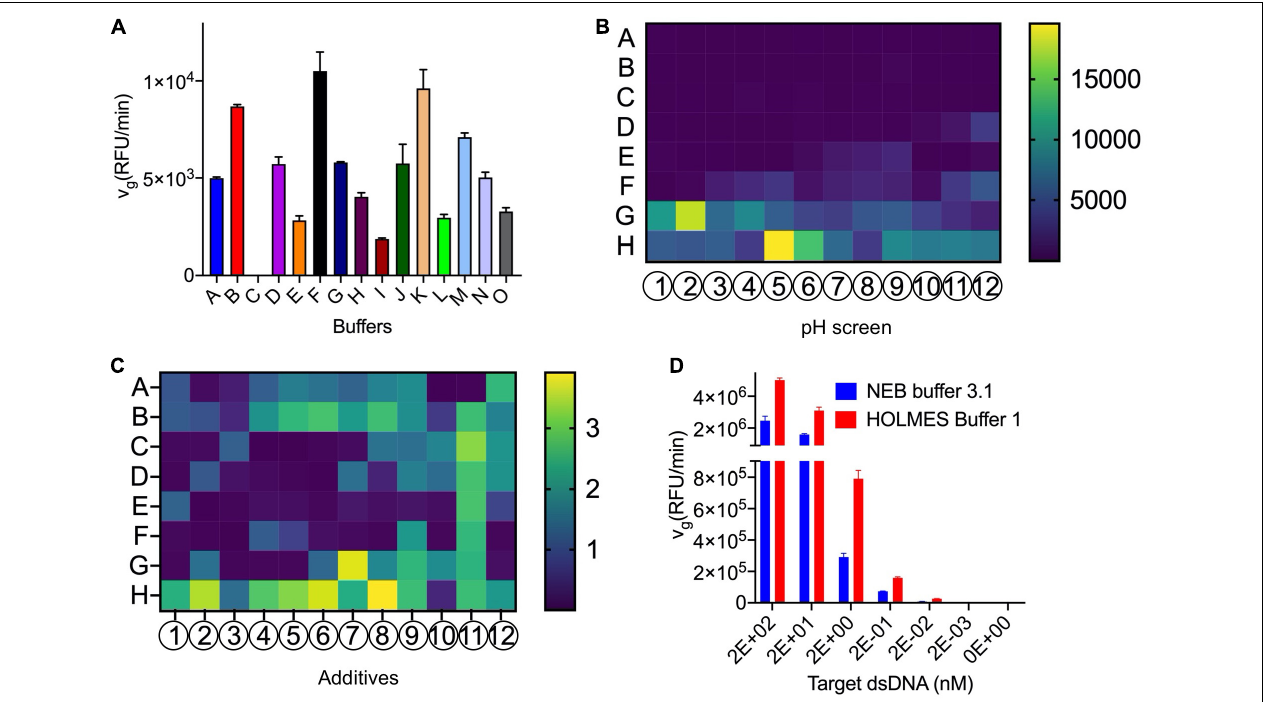
FIGURE 2 | Optimization of the Cas12a trans -cleavage reaction buffer. (A) Screening of the commercially available buffers. Detailed compositions of the tested buffers were listed in Supplementary Table 1 . (B) Screening of the pH values with the pH slice plate (Cat. No. #HR2-070) from Hampton Research. The A–H and 1–12 indicated the positions in the 96-well plate and detailed components in each well were shown in Supplementary Sheet 1 . Specifically, Cas12a in conditions of H5 ( pH 8.6 in 1 M glycine buffer) and G2 ( pH 8.5 in 1 M Tris–HCl buffer) showed obviously higher trans -cleavage activities and the Tris buffer with pH 8.5 was finally chosen for further analysis. The trans -cleavage activities (RFU/min) were reflected by the colored histogram on the right side. (C) Screening of additives with the plate (Cat. No. #HR2-072) from Hampton Research. The A–H and 1–12 indicated the positions in the 96-well plate and detailed components in each well were shown in Supplementary Sheet 2 . In comparison with the water control in A1, the Cas12a showed obviously higher trans -cleavage activities with several additives such as the G7 (glycerol), H5 (PEG 3,350), H6 (PEG 8,000), and H8 (PEG 20,000), and the most efficient H8 was employed for further analysis. The fold changes, relative to the activities in A1, were indicated by the colored histogram on the right side. (D) Comparison of the v g of Cas12a in HOLMES Buffer 1 and NEB buffer